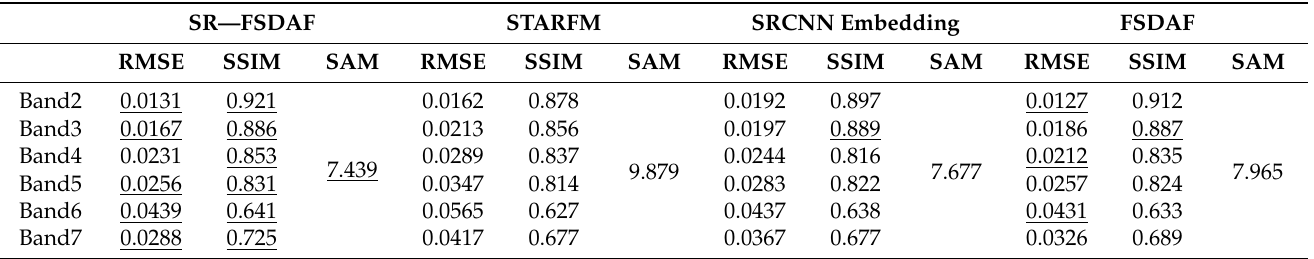
Table 5. Comparison of fusion accuracy of heterogeneous mutation